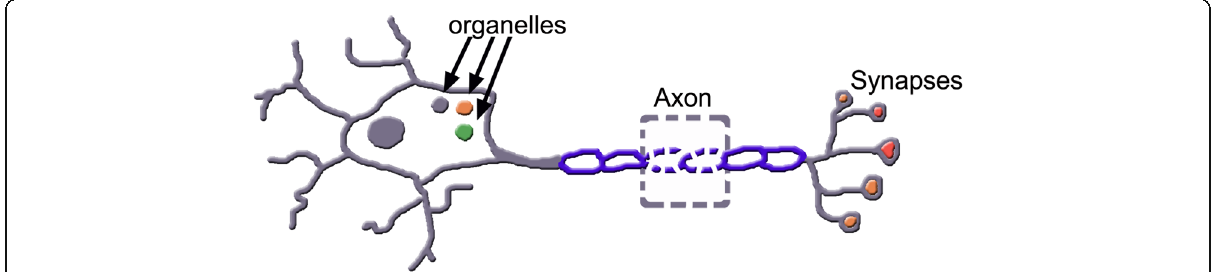
Fig. 3 A neuron of the ALS disease shows alteration of variously distributed structures: from the cytoplasm, axon and synapses. Organelles of the cytoplasm include mitochondria (pink), lysosomes (green) and others; an axon includes two altered myelins (dashed lines) as well as several, variously altered presynaptic structures